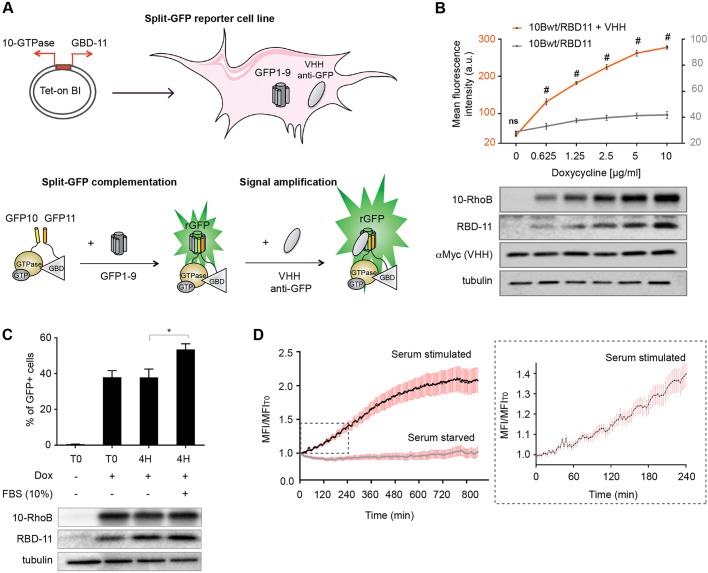
triSFP RhoB activation reporter cell model. (A) A bidirectional inducible promoter vector co-expressing GFP10–Rho and RBD–GFP11 chimera was used to transduce MRC5-SV fibroblasts expressing the GFP1-9 fragment and the VHH anti-GFP nanobody. Binding of the nanobody to rGFP enhances its fluorescence. (B) Doxycycline dose–response rGFP fluorescence in MRC5_GFP1-9 in the presence (+VHH) or in the absence (−VHH) of the anti-GFP intrabody. Results are mean±s.e.m.; n=3 independent experiments. #P<0.0001; ns, not significant (Holm–Sidak t-test with α=5%). Control of protein expression is shown in the western blot below the graph (anti-GFP10 and anti-GFP11 antibodies; anti-Myc for VHH). (C) Flow cytometry analysis of serum-induced activation. RhoB activation reporter was expressed with 2.5 µg/ml doxycycline (Dox+), and the cell line was subjected or not to serum stimulation (4 h) after a starvation period of 48 h (T0). Results are mean±s.e.m.; n=3 independent experiments. *P<0.05 (paired Student's t-test). The immunoblot below the graph shows GFP10–RhoB and RBD–GFP11 expression for the indicated conditions. (D) Single-cell analysis of RhoB activation by time-lapse microscopy. Plot of the ratio of cellular mean fluorescence intensity (MFI) to basal MFI measured at T0 (MFIT0) for serum-starved and serum-stimulated cells [n=20 cells from four (serum stimulation) and five (serum starvation) independent experiments; mean±s.e.m.]. An enlargement is shown on the right for serum-stimulated condition (0–240 min).